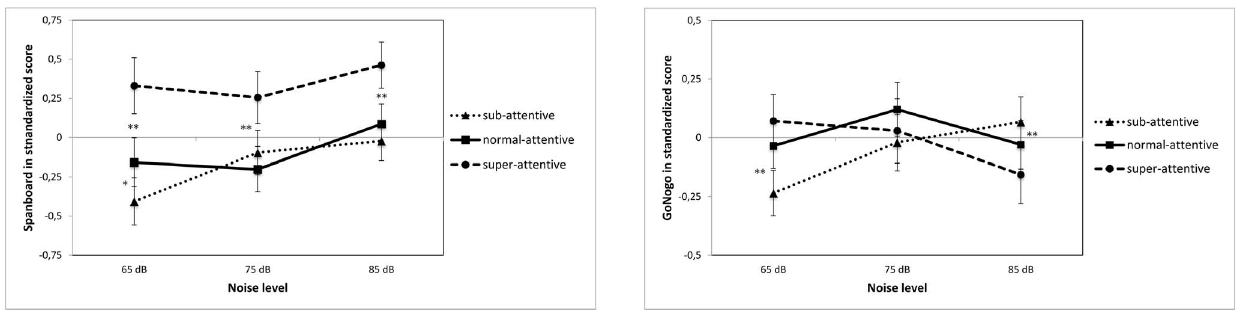
Figure 4. Figure 4A. Performance on Go/No-Go task (executive) as a function of attention ability and noise level. Note: White noise levels were 65, 75, 85 dB. ** (p , .001) indicates significant differences between super- and sub attentive in 65 and 85 dB conditions. Figure 4B. Performance on Spanboard task (executive) as a function of attention ability and noise level. Note: White noise levels were 65, 75, 85 dB. * (p , .05) and ** (p , .001) indicates significant differences between groups.